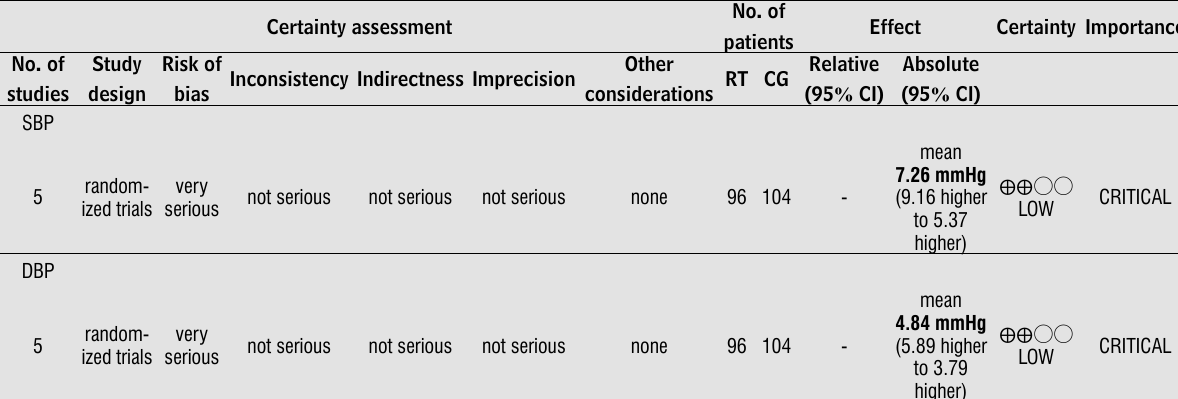
Table 5 – Level of evidence with Grading of Recommendations Assessment, Development and Evaluation of the meta- analysis (GRADE) Certainty assessment